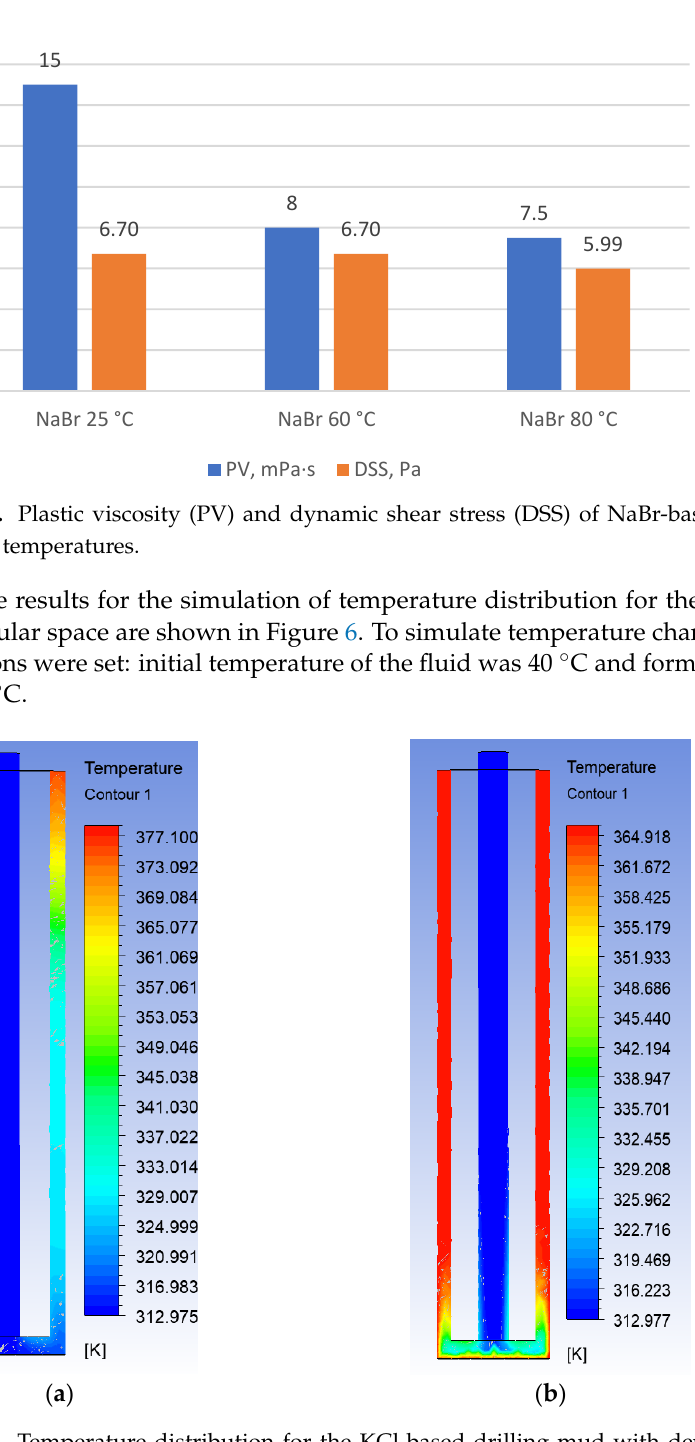
Figure 6. Temperature distribution for the KCl-based drilling mud with density of 1.18 g/cm 3 ( a ) and NaBr-based drilling mud with density of 1.56 g/cm 3 ( b ) in the annular space of the well .